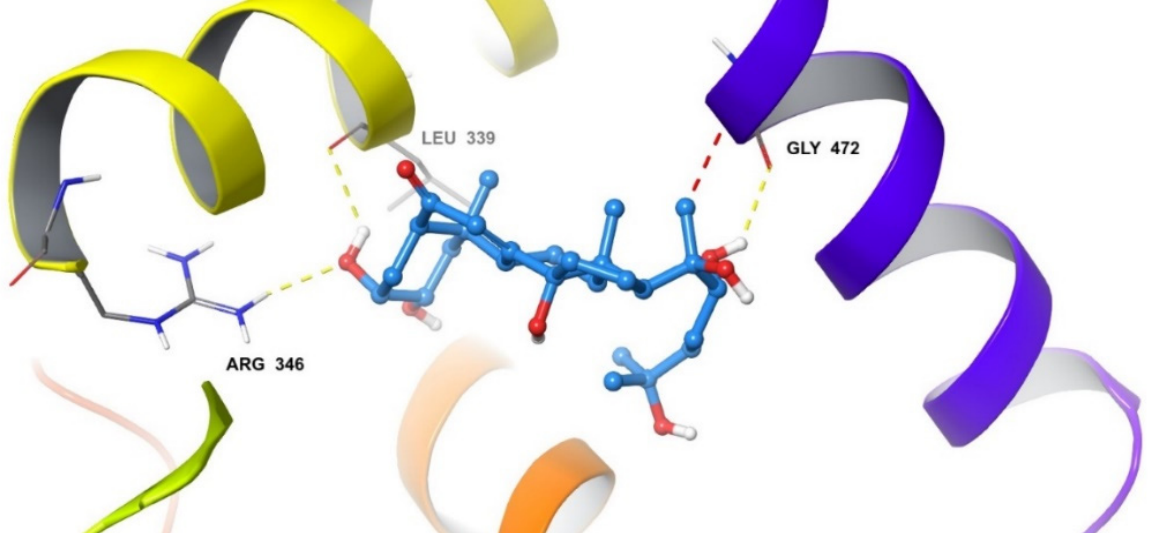
Figure 3. Overlay of the ligand 20-HE (cyan) and the co-crystallized ligand estradiol (green) in the binding cavity of ER β . Hydrogen bonds are displayed with yellow dashed lines, while steric clashes are displayed in red dashed lines.